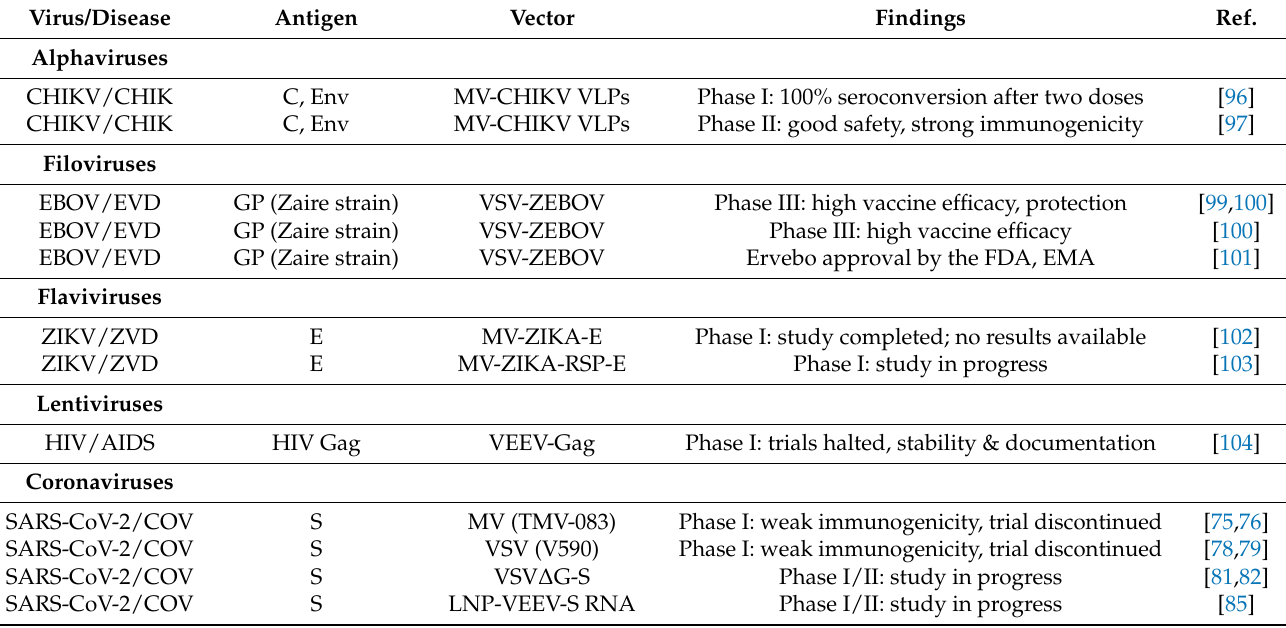
Table 2. Examples of clinical studies on self-replicating RNA viral vector vaccines against infectious diseases. Virus/Disease Antigen Vector Findings